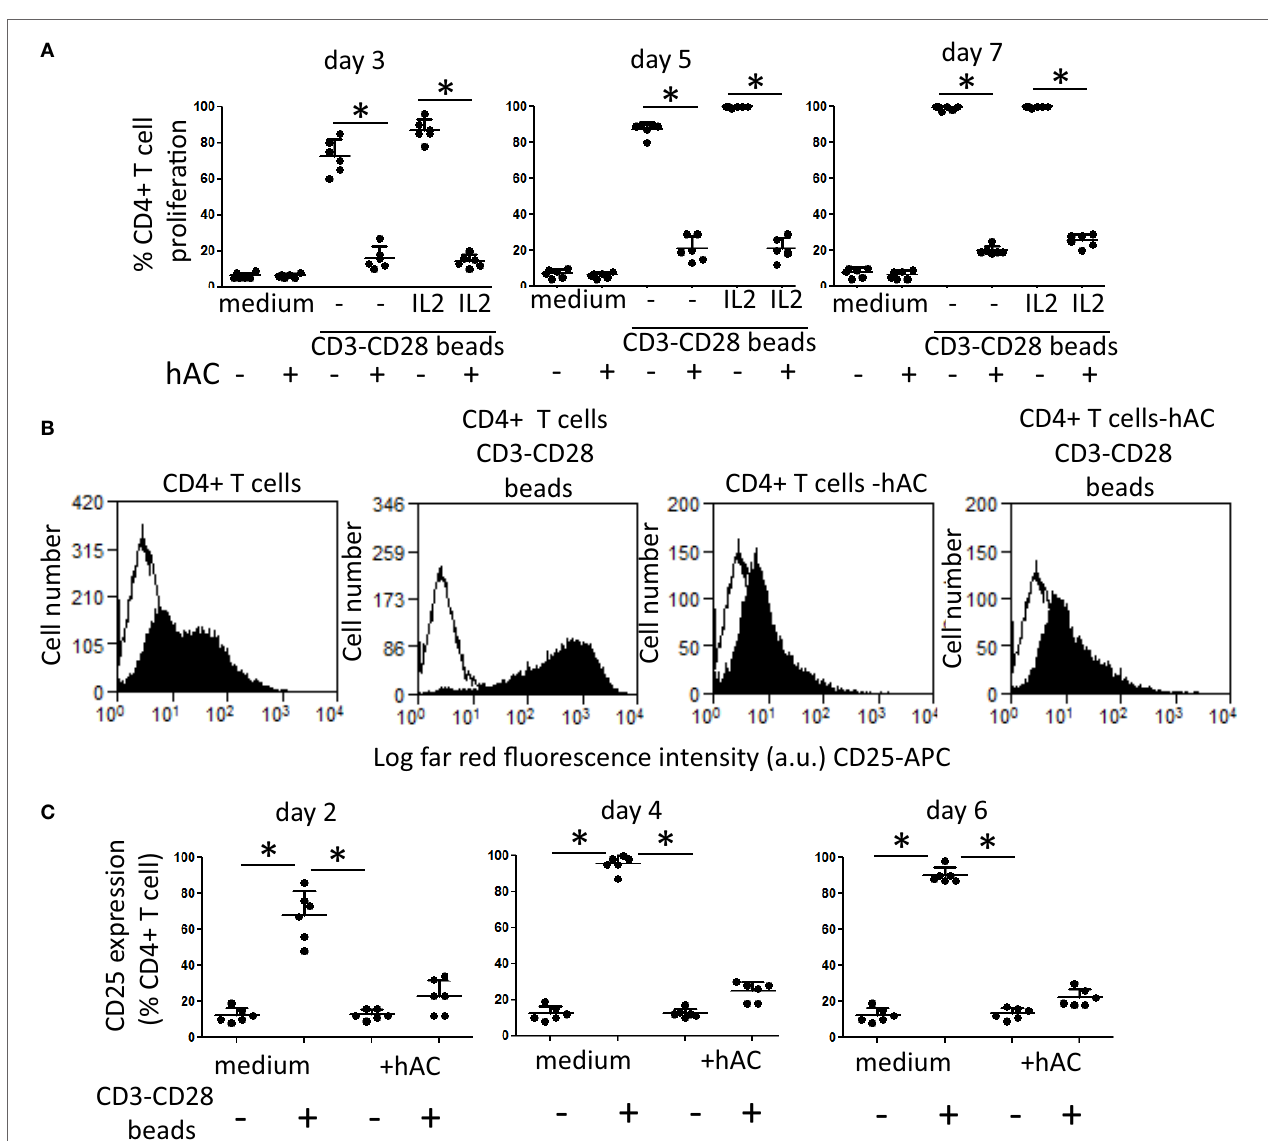
FigUre 3 | effect of hac on cD4 + T cell proliferation and il-2r expression triggered through the engagement of cD3 and cD28 surface receptors . (a) CD4 + T cell proliferation to coated beads with anti-CD3 and anti-CD28 mAb at the time points indicated (3, 5, and 7 days). IL-2 (2 ng/ml) was added on day 2 of culture. Medium: proliferation of CD4 + T cells without mAb-coated beads. Results are the mean ± SD of six independent experiments. * p < 0.001 of CD4 + T cell-hAC co-cultures vs. CD4 + T cells alone. (B,c) CD4 + T cells stimulated with CD3–CD28 beads were analyzed for the expression of CD25 (IL-2R α chain) on day 2 (B,c) 4 and 6 (c) by indirect immunofluorescence using specific anti-CD25 mAb followed by isotype specific Alexafluor 647-conjugated goat anti-mouse and FACS analysis. Medium: expression of CD25 antigen in the absence of stimuli. (B) A representative experiments out of the six depicted in (c) . Results in (c) are the mean ± SD of six experiments performed with different donors of CD4 + T cells and four donors of hAC. * p <